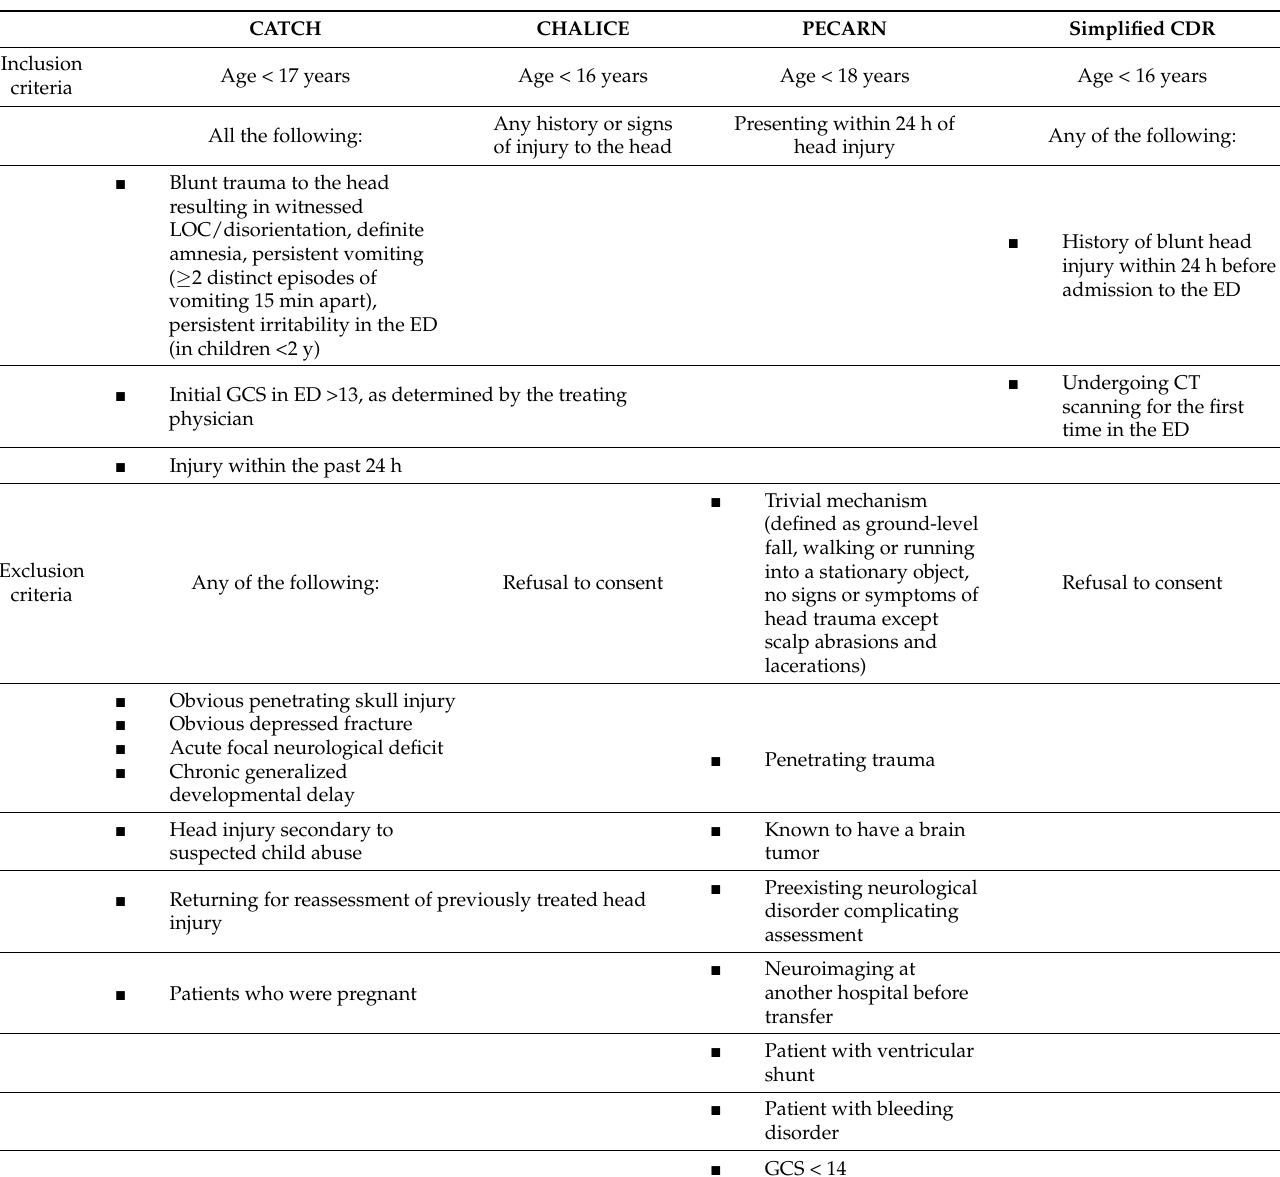
Table 1. Comparison of patient selection criteria in the clinical decision